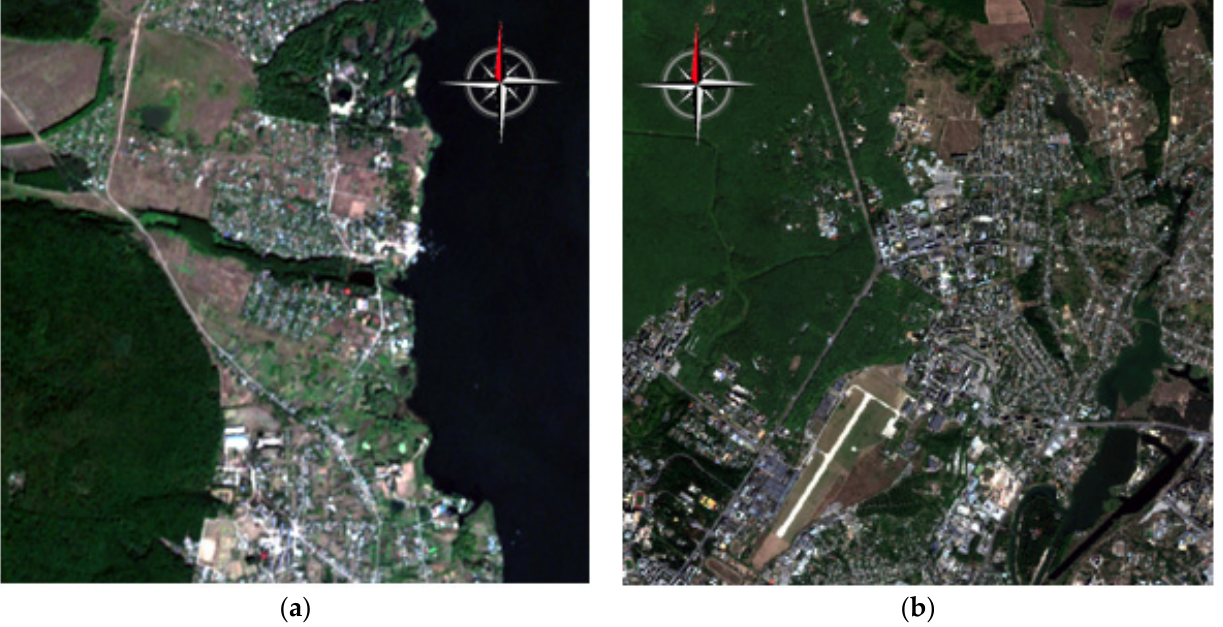
Figure 12. Test images SS3 ( a ) and SS4 ( b ): real life Sentinel-2 images for country-side ( a ) and city ( b ) areas in Kharkiv region, Ukraine. Table 4. Results of compressing SS3 and SS4 using DAC with DAT1 of the depth 5.